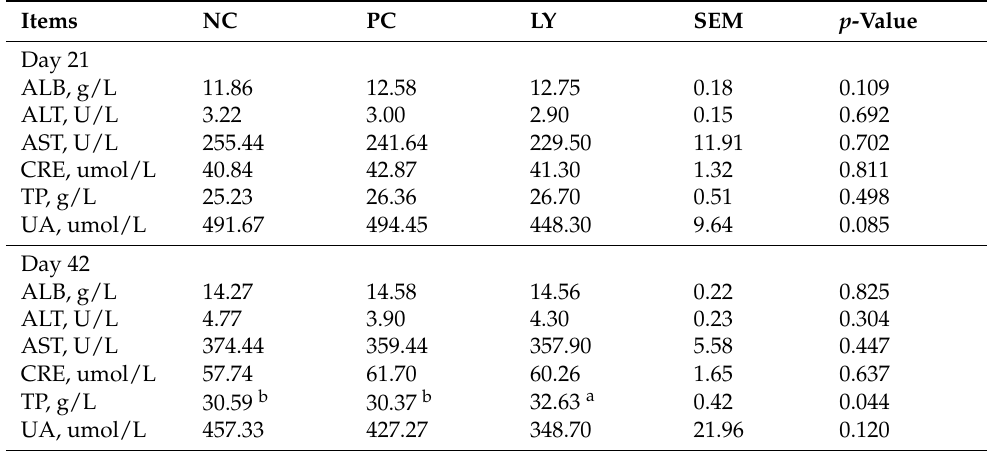
Table 3. Effect of dietary treatments on the serum biochemical indexes of